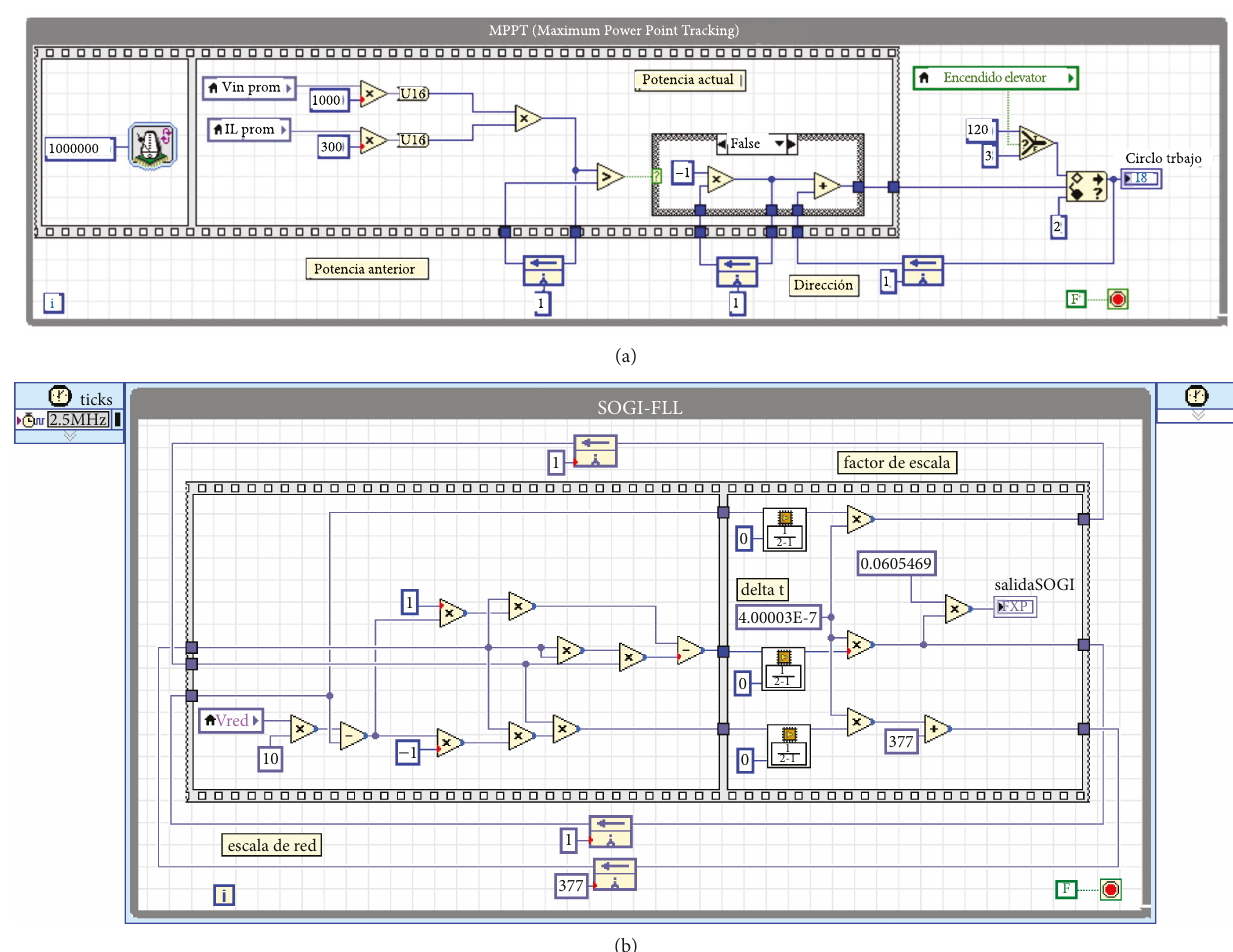
Figure 4: LabVIEW control blocks implemented on the CompactRIO platform. (a) MPPT algorithm. (b) Synchronization